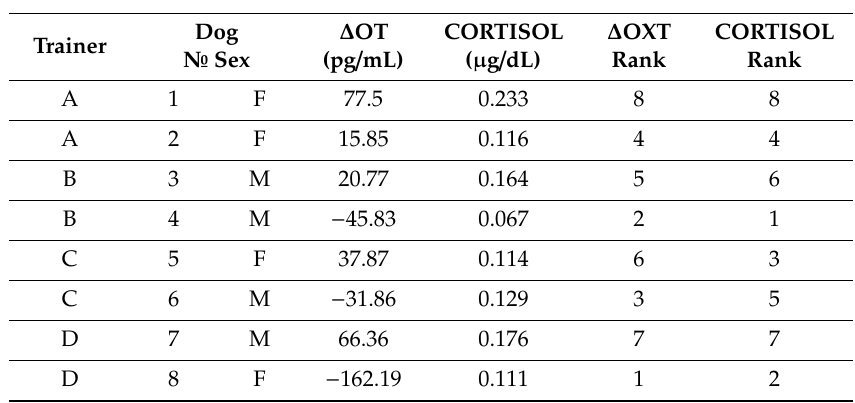
Table 3. Salivary Δ OXT (oxytocin (T1)–(T0)) and cortisol concentration during NC (negative condition, consisting of 5 min of isolation).